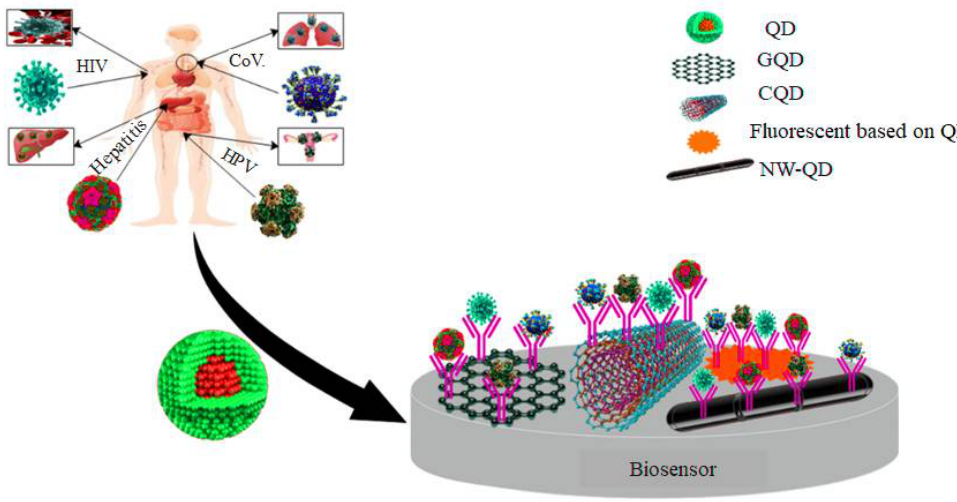
Figure 1. QD-based nanosensors to detect